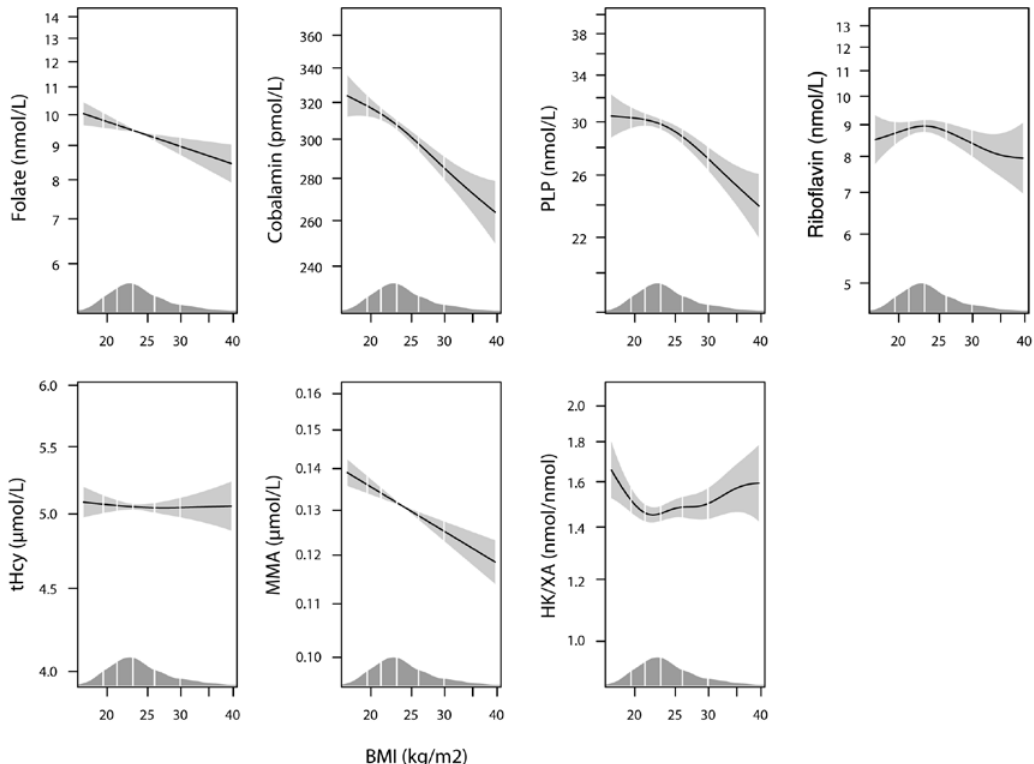
Figure 1. The association of pre-pregnancy BMI with cobalamin, folate, PLP, riboflavin, tHcy, MMA, and HK/XA by generalized additive models (GAM), adjusted for use of multisupplements, maternal age, parity, and neopterin. The solid line shows the fitted model and the shaded areas indicate 95% CIs. PLP, pyridoxal 5 ′ phosphate; tHcy, total homocysteine; MMA, methylmalonic acid, HK/XA, 3-hydroxykynurenine/xanthurenic acid ratio.